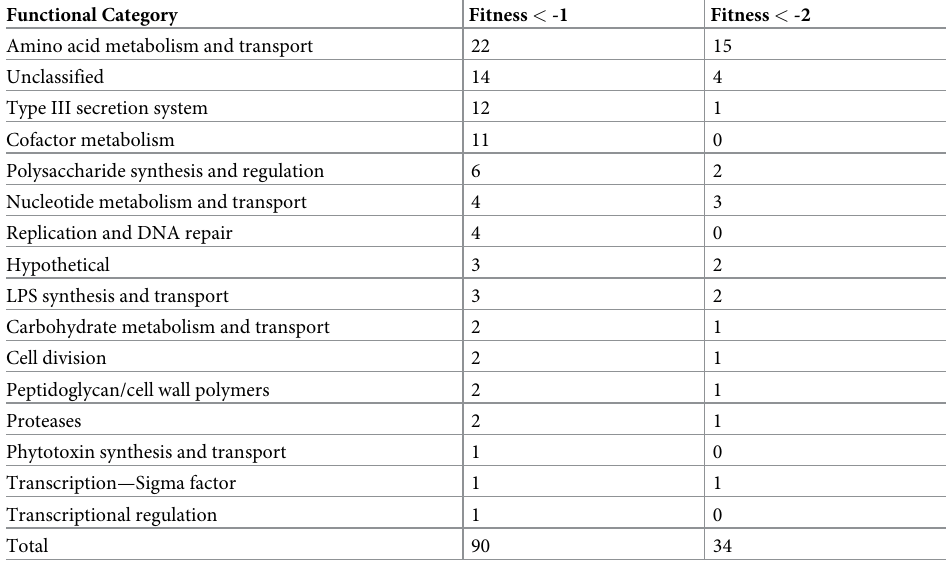
Table 1. Number of genes within each functional category with significant contributions to apoplastic fitness in all three host plant species